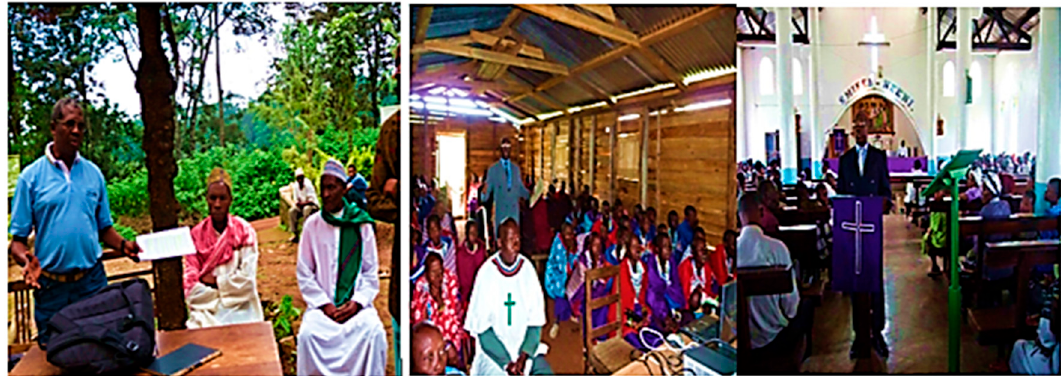
Figure 5. The Chief engineer of Hai and Siha pictured left, in the middle and right engaging Islamic and evangelical church leaders on rural water supply issues [Fieldwork data, 2017] [37].